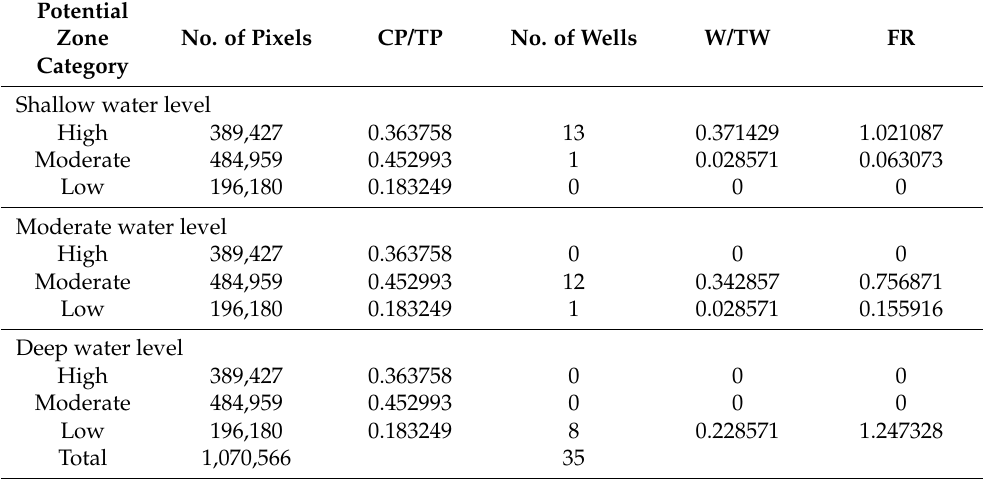
Table 7. Frequency ratio between water level and amalgamated groundwater potential